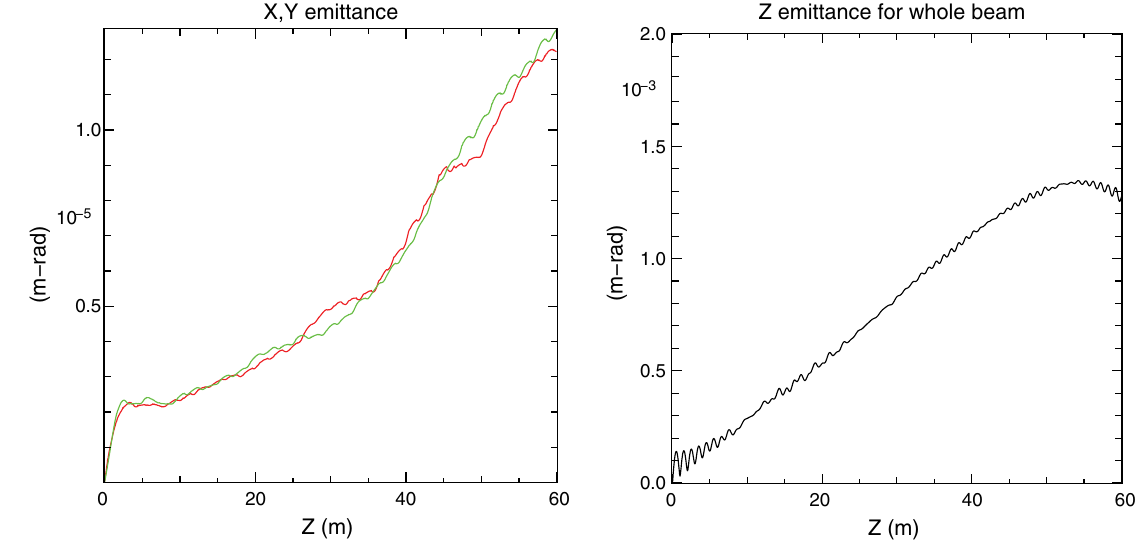
FIG. 5. One example of central slice x (red), y (green) emittances vs z and whole beam z emittance vs z ; all emittances are initially zero.